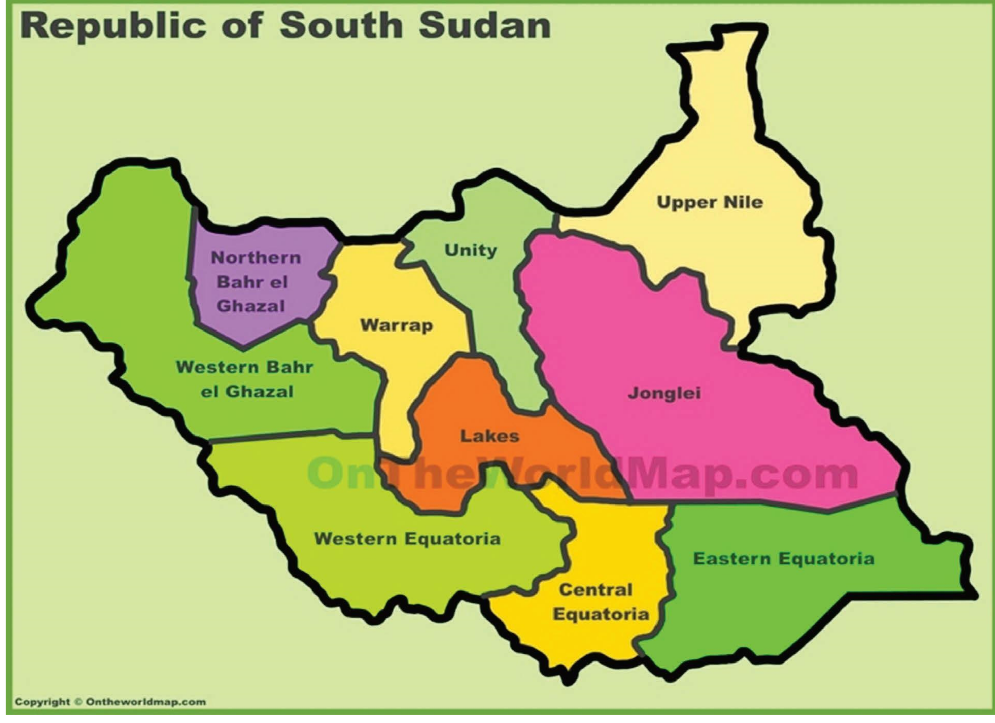
Figure 1: Map of the study